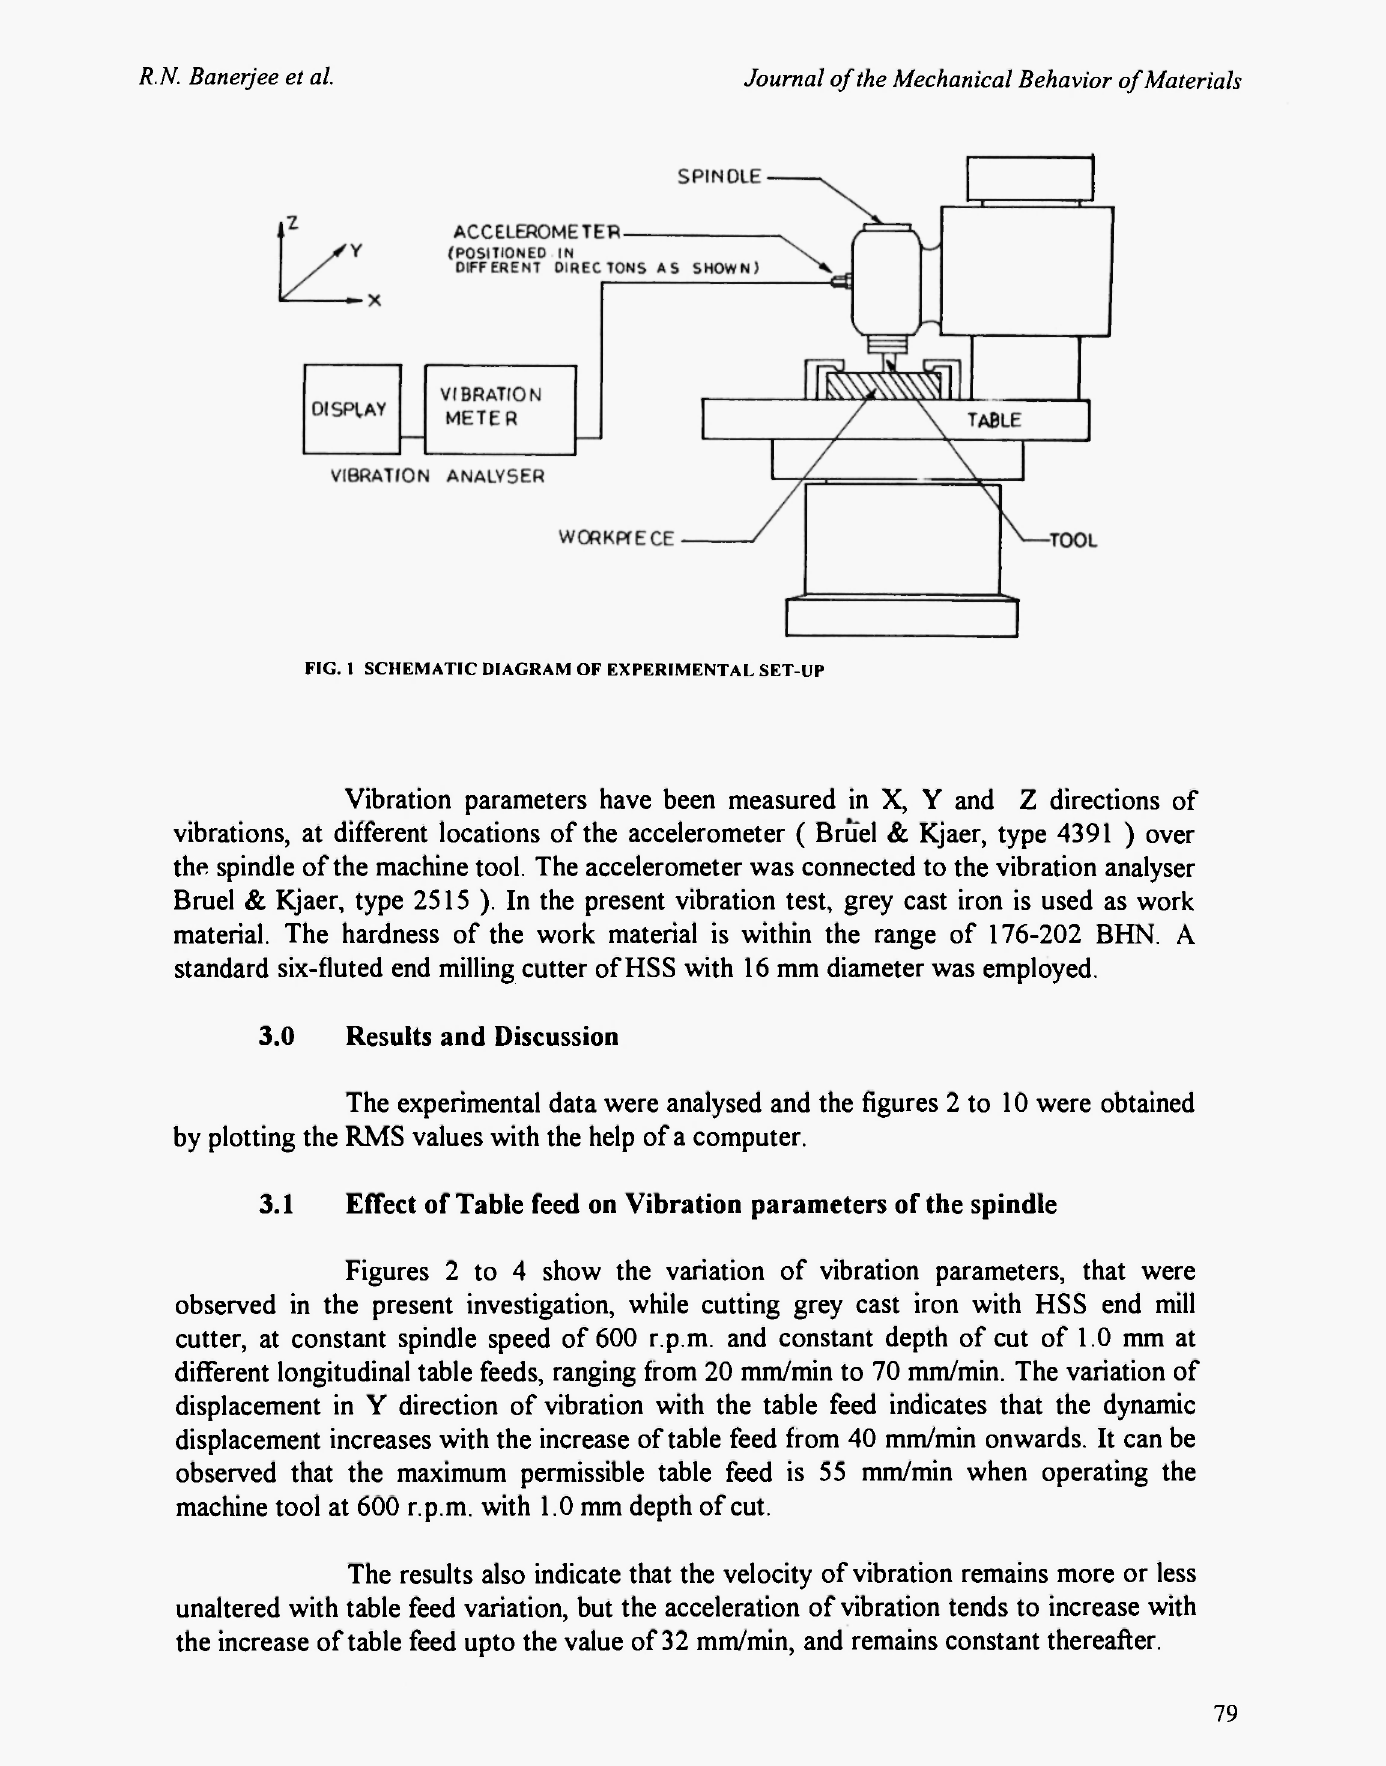
FIG. 1 SCHEMATIC DIAGRAM OF EXPERIMENTAL SET-UP